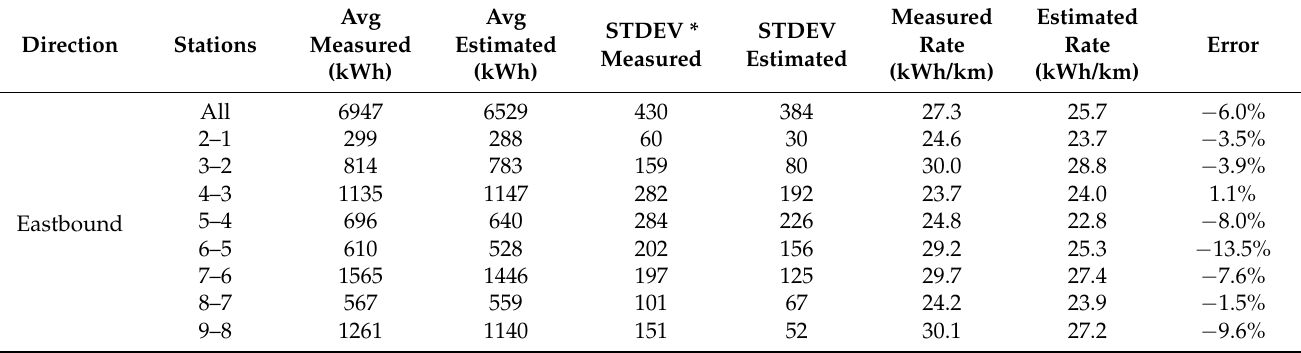
Table 5. Model evaluation for station